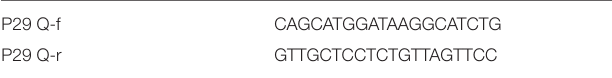
TABLE 1 | Primer set used in the real-time polymerase chain reaction